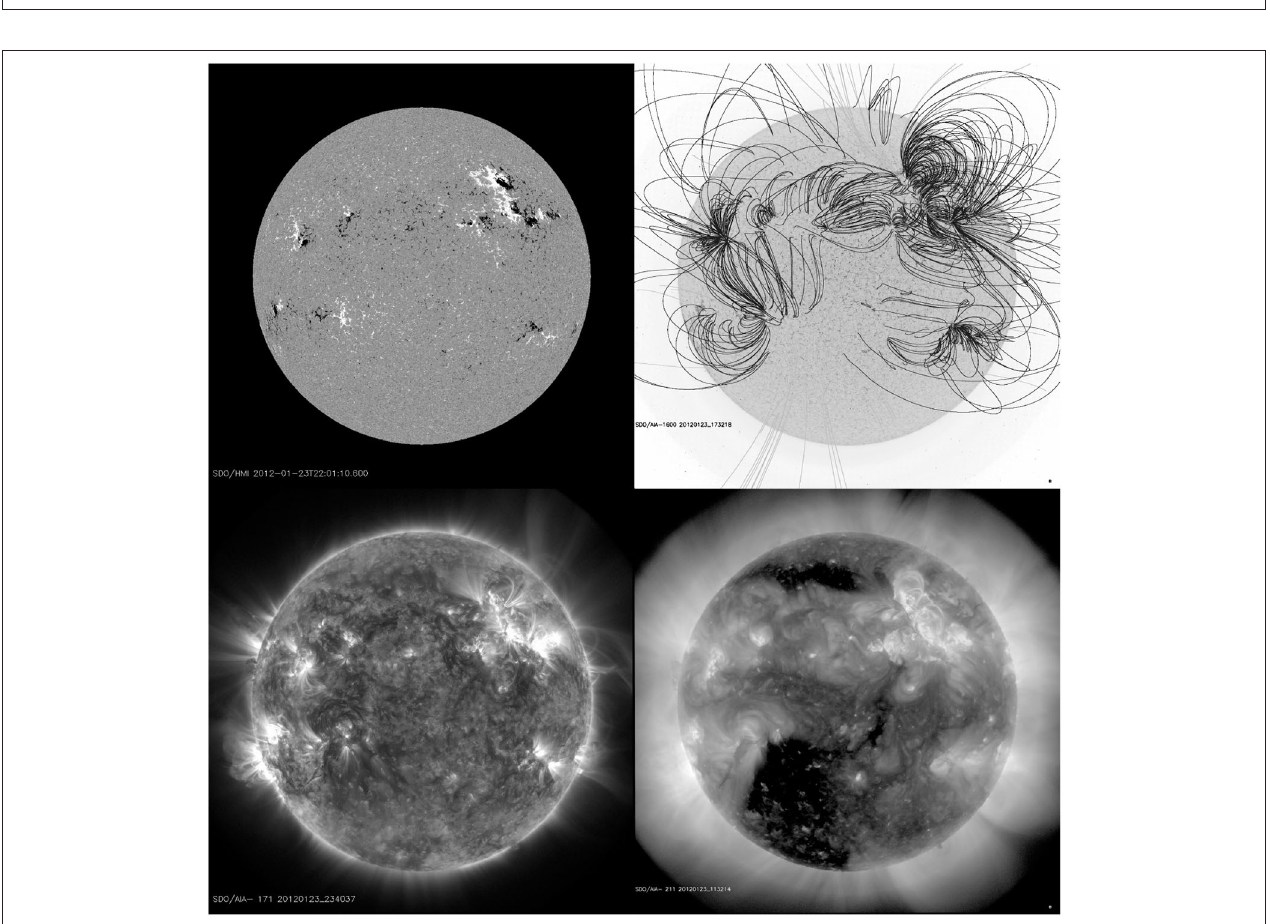
FIGURE 12 | A full disk HMI/SDO magnetogram (top left) with extrapolated magnetic field lines (top right), the upper TR observed in the 171Å (Fe VIII ) band (bottom left) and the corona observed in the 211Å (Fe XIV ) band (bottom right) with AIA/SDO on January 23, 2012. Images adapted from http://suntoday.lmsal.com/suntoday/.